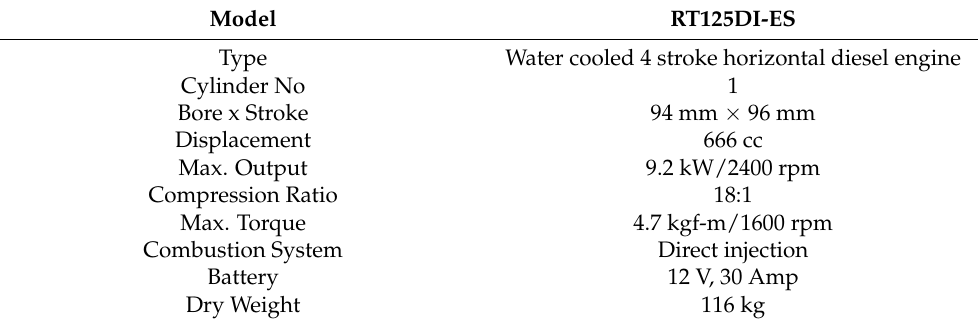
Figure 1. Schematic diagram for the experimental setup. Table 1. Engine